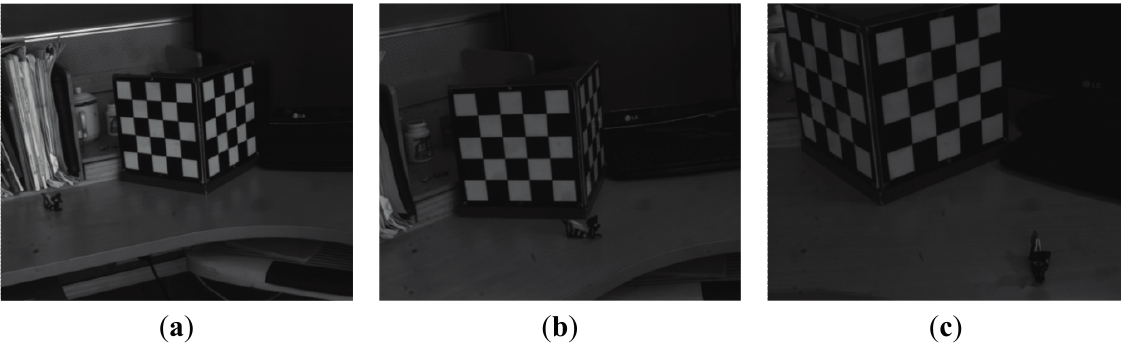
Figure 4. The part images of sequence for 2D reconstruction. ( a ) The 1st image; ( b ) The 5th image; ( c ) The 11th